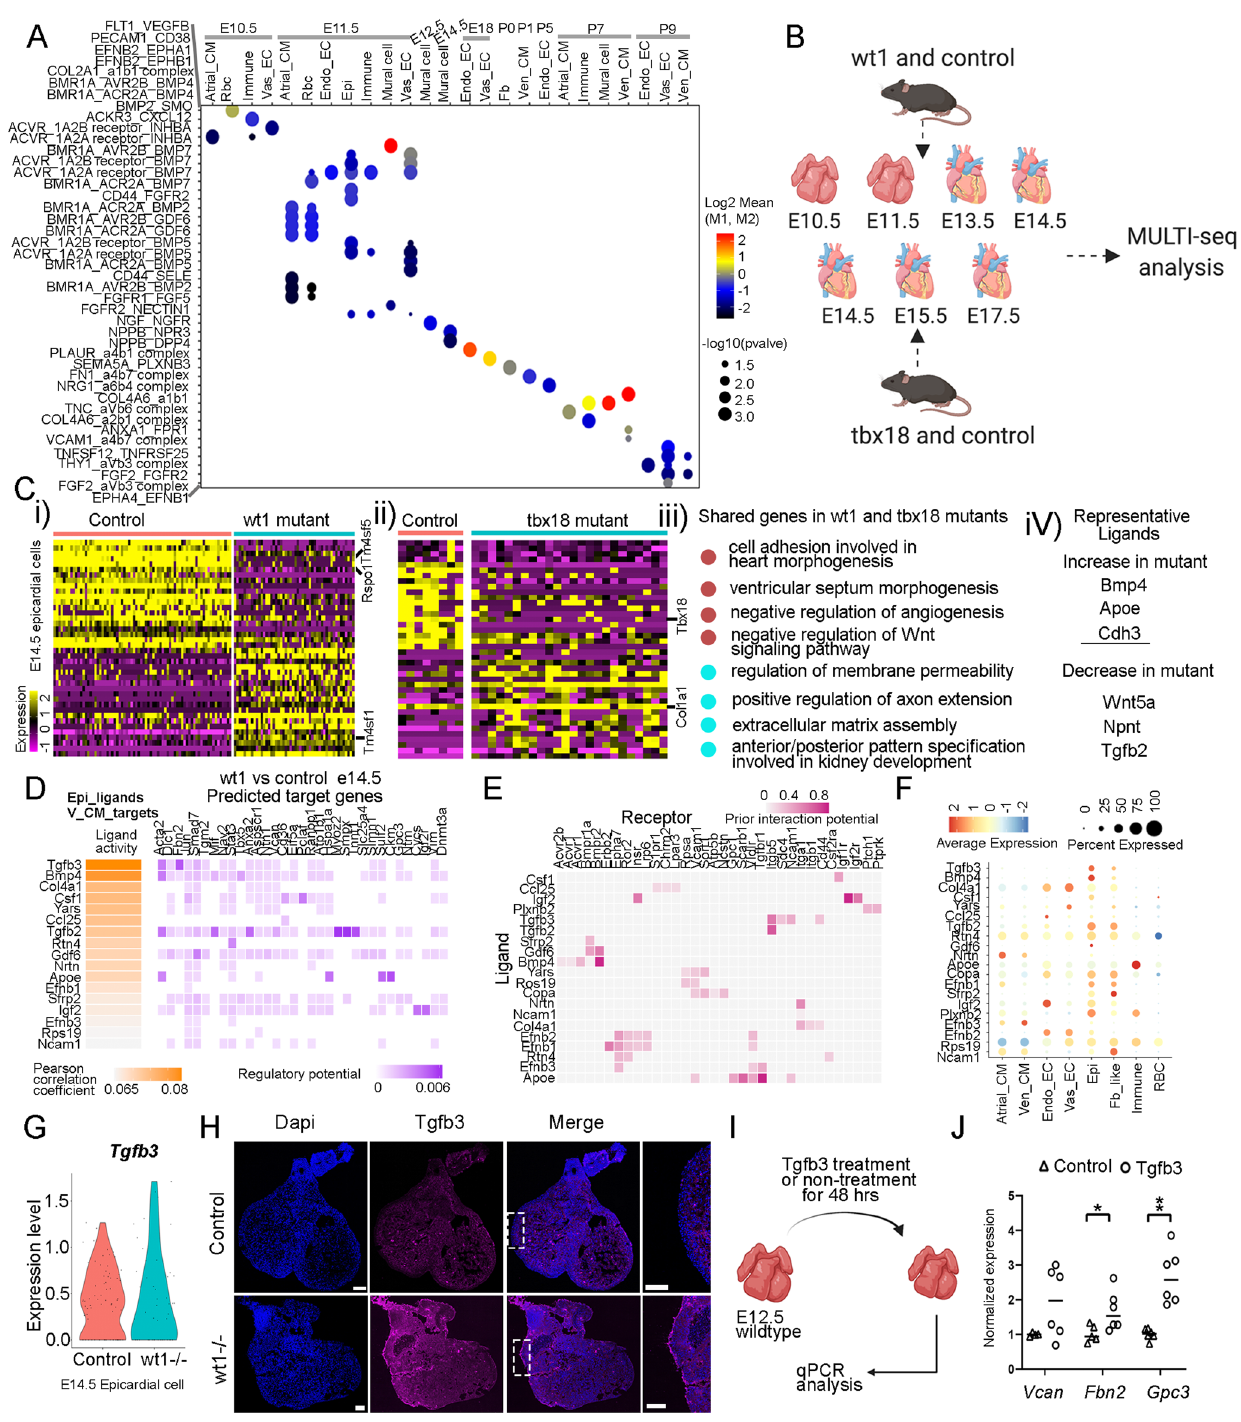
Fig. 8 | ScRNA-seq analysis of Wt1 and Tbx18 mutant hearts at multiple stages. A The stage-unique interactions between ligands from epicardial cells and recep- tors expressing in other cell types at different stages. B Diagram of the pro fi led samples and their derived developmental stages. This fi gure was created with BioRender.com. C (i,ii)Expressionheatmapofthedifferentiallyexpressedgenesin control and Wt1 or Tbx18 mutant epicardial cells at E14.5. (iii) Pathway enrichment of abnormally expressed genes shared by Wt1 and Tbx18 mutant epicardial cells. (iv) Representative ligands with abnormal expression in Wt1 and Tbx18 mutant epicardial cells. D – F The activity and expression pattern of epicardial cell-derived ligands and their prior interaction potentials with receptors and regulatory